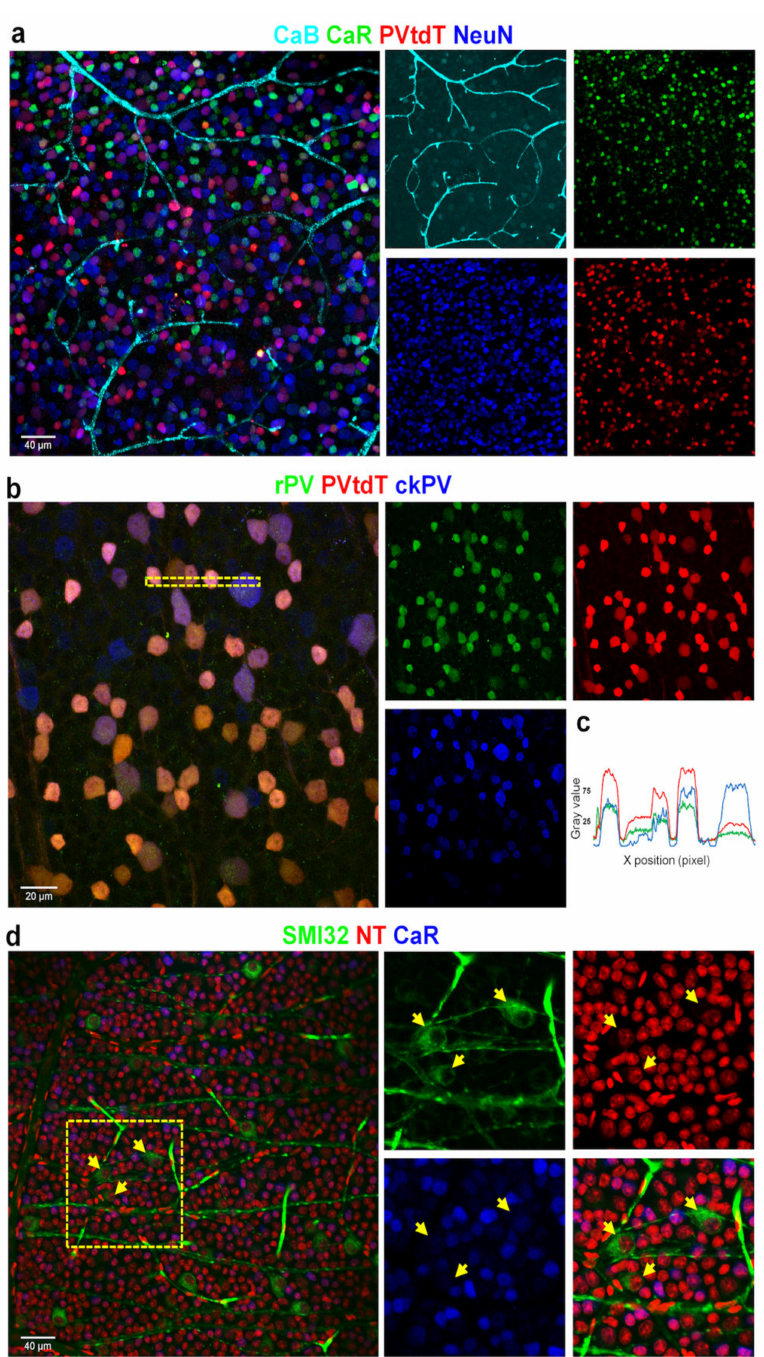
Figure 8. Correlating multiple labels with CaBPs can help reveal individual di ff erences between antibodies and GC identity. Panel ( a ) shows the parvalbumin-tdTomato (PV-tdT) GMO mouse retina with CaB, CaR, and NeuN labeling (composite image on the left and split into four channels on the right—all colors correspond to the label above). Panel ( b ) displays the comparison between PV-tdT, rabbit-PV(rPV),andchicken-PV(ckPV)antibody-labelingperformedonthesameretina. ( c )Ahistogram profile, acquired from the dashed area in b shows a variance in normalized relative intensities of the PV-tdT (GMO, red) and r- (green), ckPV (blue) labels. ( d ) ON and OFF GCs (ganglion cells) are brightly labeled with SMI32 (arrows) but not by CaR. CaR, on the other hand, labels smaller GCs not labeled by SMI32. Neurons and vascular cells are all labeled with the fluoro-Nissl stain Neurotrace-640 / 660